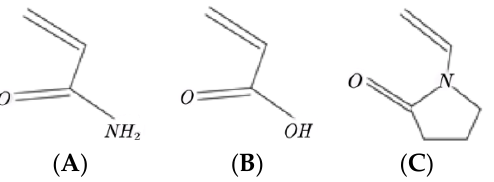
Figure 1. Structure of the main chain monomer. ( A ) AM (acrylamide); ( B ) AA (acrylic acid); ( C ) NVP (N-vinylpyrrolidone).